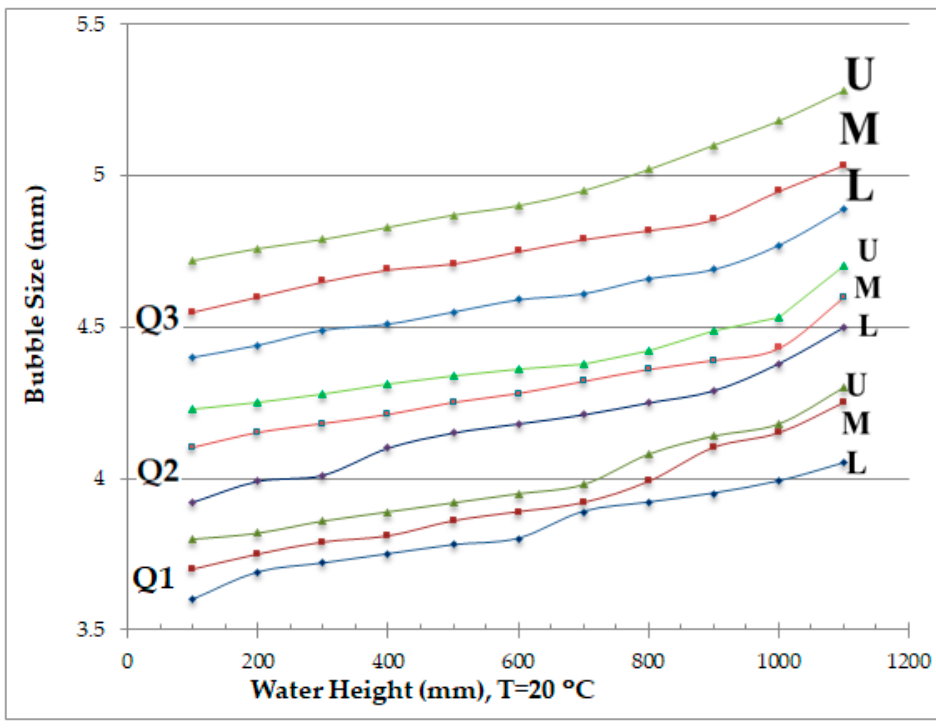
Figure 3. A sample of bubble size as a function of water height for T = 20 ° C.